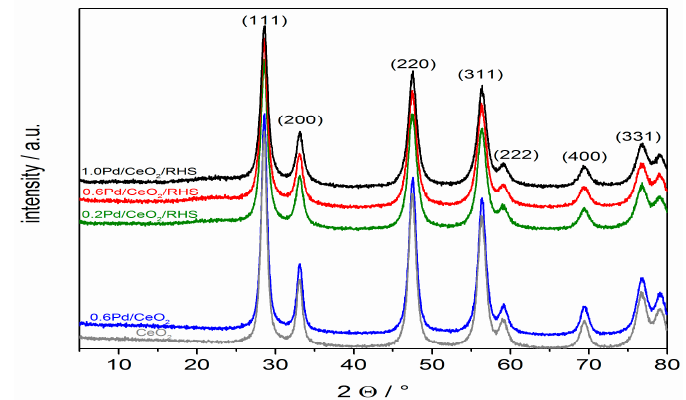
Figure 3. XRD (X-ray diffraction) patterns of CeO 2 , 0.6Pd/CeO 2 and x Pd/CeO 2 /RHS.